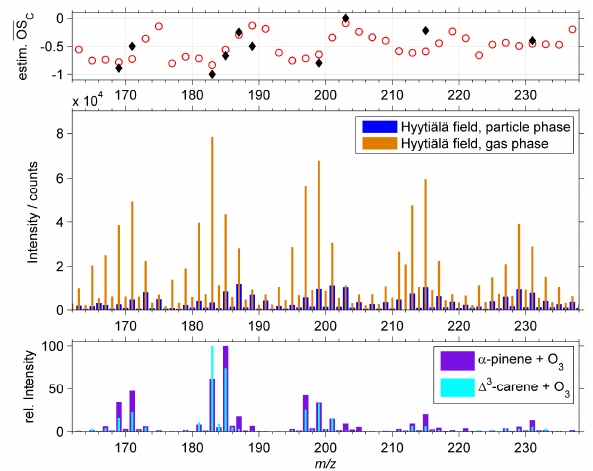
Figure 4. Top panel: Estimated average oxidation states (red circles) derived from oxidation 2 Fig. 4. Top panel: estimated average oxidation states (red circles) derived from oxidation states of literature terpenoid organic acids states of literature terpenoid organic acids (black diamonds, see Tab. 2). Middle panel: 3 (black diamonds; see Table 1). Middle panel: average spectrum Average spectrum of organic acids in the ambient air measured with APCI-IT-MS in the 4 of organic acids in the ambient air measured with APCI-IT-MS negative mode on day 207 (26 July 2010 12:00 – 15:00h (UTC+2)). Bottom panel: Average 5 in the negative mode on day 207 (26 July 2010, 12:00–15:00LT spectrum of laboratory dark ozonolysis experiments with (cid:302) -pinene and (cid:507) 3 -carene. 6 (UTC + 2)). Bottom panel: average spectrum of laboratory dark ozonolysis experiments with α -pinene and 1 3